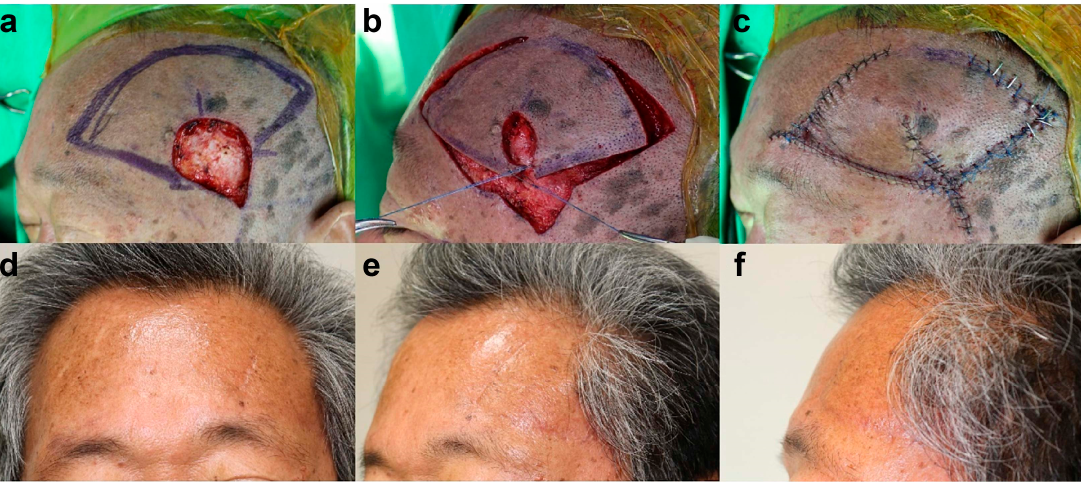
Figure 5. Clinical photographs of case 9. ( a ) Skin defect (4 cm × 4.5 cm) in the temporal forehead, and design of the keystone perforator island flaps (KPIF) (6.5 cm × 12 cm) from the temporoparietal scalp and lateral forehead. ( b , c ) Successful defect coverage with the Sydney melanoma unit modification and omega variation closure KPIF. ( d – f ) Postoperative photographs after an 8-month